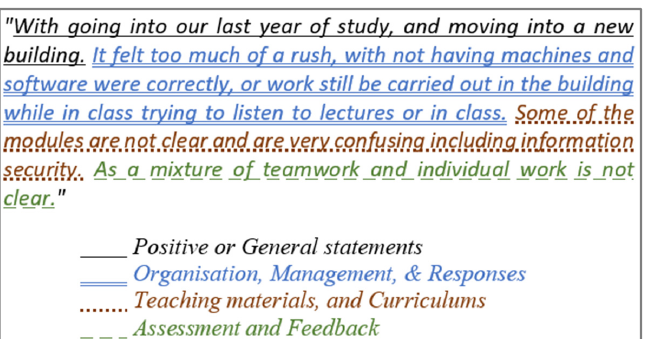
Figure 5. Example of a single student response consisting of multiple problem statement categories.